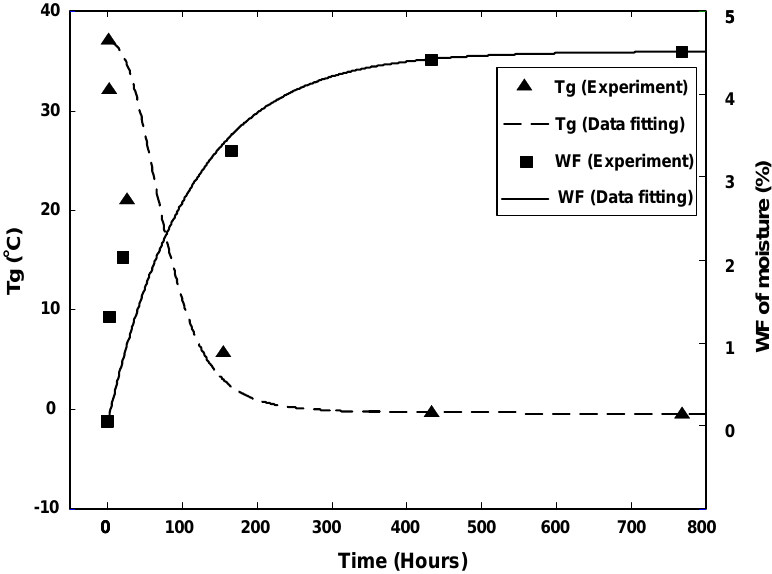
Figure 3. Changes in the SMPU’s T and weight fraction (WF) of moisture vs. immersion g time in water (20 °C). Reprinted with permission from [217] (© 2010, Institute of Physics